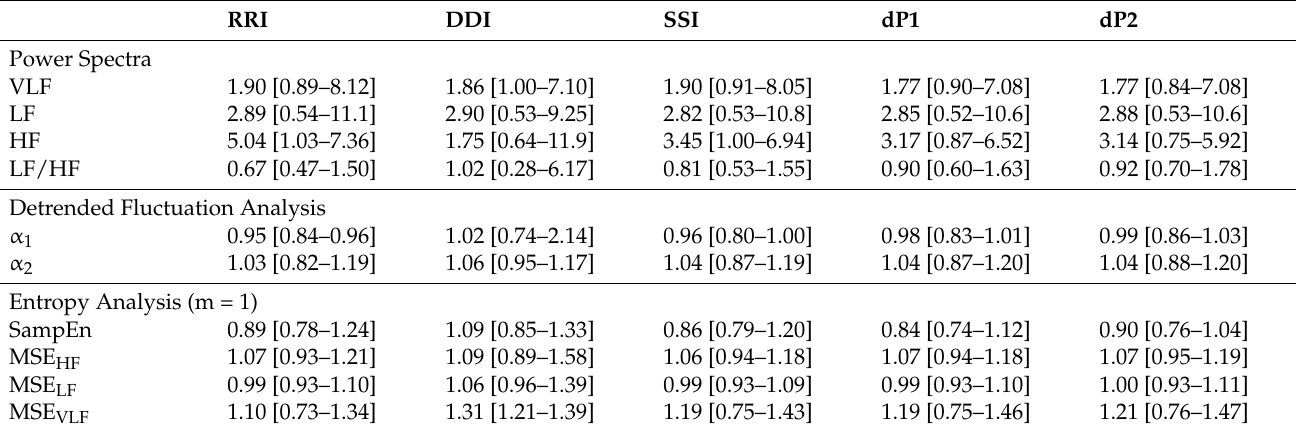
Table 3. HRV indexes in n = 4 climbers: median [range] of the ratio between measures taken at Camp 2 and